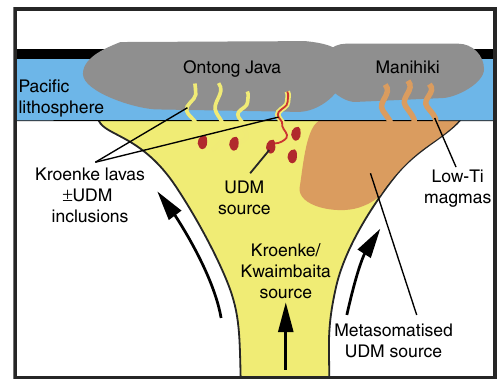
Figure 5 | A schematic model for the formation of the Ontong Java and Manihiki Plateaus from a geochemically heterogeneous mantle-plume head. The presence of ultra-depleted melts at OJP and Manihiki (UDM) can be explained with a geochemically heterogeneous plume head containing different components beneath the two plateau segments. Beneath OJP, the dominant Kroenke/Kwaimbaita source component upwells and generates the dominant Kroenke/Kwaimbaita basement lavas with flat primitive-mantle-normalized incompatible element patterns. The presumed Fig. 3, dominant source component beneath Manihiki is the UDM end member metasomatized by r 1% HIMU-type melts. We propose that both components beneath Manihiki are derived through recycling of Indian-mantle-like oceanic lithosphere. Ultra-depleted melt inclusions in olivines in a Kroenke sample from OJP 16 indicate that smaller proportions of a possibly common UDM source may also be present beneath the